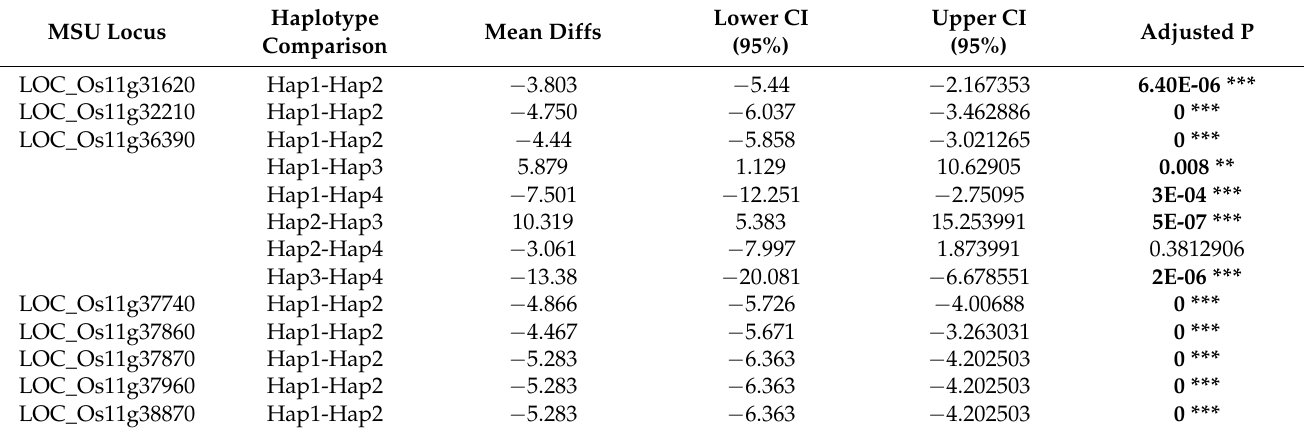
Table 3. A NOVA results of BLB resistance assays among different haplotypes determined by presence/absence of signifi- cantly associated SNPs contained within MSU gene boundaries. Bold indicates significance while *** indicates significance at the <0.0001